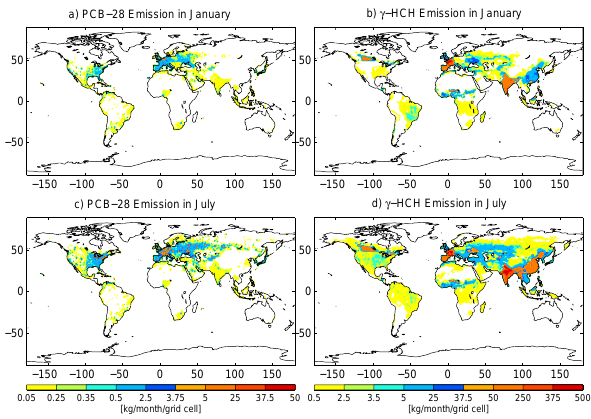
Fig. 1. Monthly emission of PCB-28 (Breivik et al., 2007, high scenario, temperature corrected) and of γ -HCH (Li et al., 2008) for January and July 2005. The emission fluxes on the logarithmic scale are given in kg/month per 1 ◦ × 1 ◦ grid